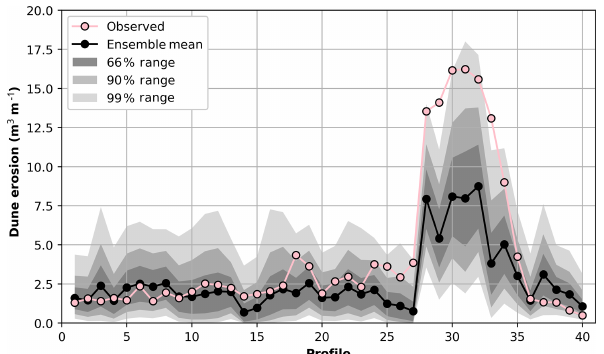
Figure 8. Observed (pink dots) and predicted (black dots) dune ero- sion volumes for the 40 modelled profiles, using 10000 runup mod- els drawn from the Gaussian process and used to force the LEH04 model. Note that the 40 profiles shown are not uniformly spaced along the 3.5km Narrabeen embayment. The black dots represent the ensemble mean prediction for each profile, while the shaded ar- eas represent the regions captured by 66%, 90%, and 99% of the ensemble